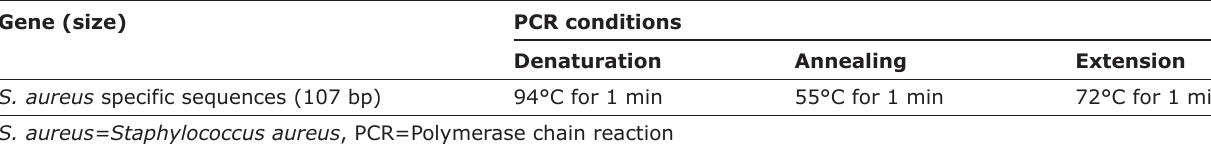
Table-2: PCR conditions for S. aureus -specific sequences-based characterization. Gene